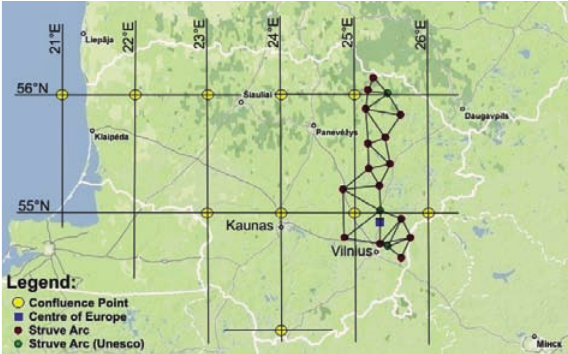
Fig. 1. Location of Various Special Points in